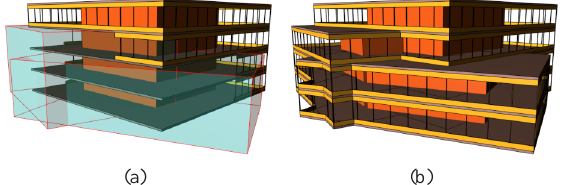
Figure 16: Freeform office: (a) To avoid undesirable interior walls, the walls inside the other building parts are cut away using a CSG operation. (b) The result of the